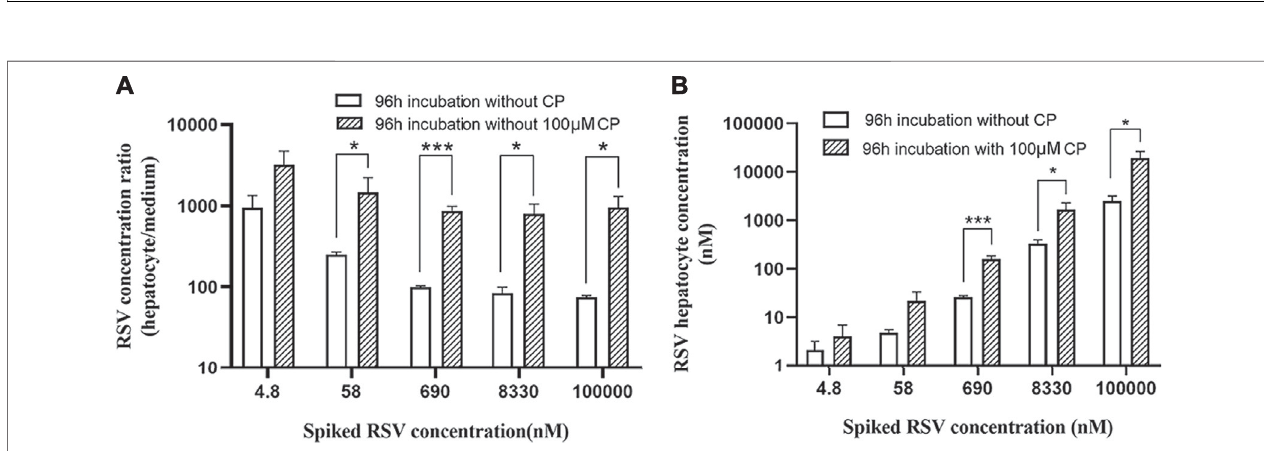
FIGURE 4 | Cell to medium concentration ratio (A) and intracellular concentration of RSV (B) in the presence and absence of CP after 96 h incubation. Data are presented as the mean ± S.D. (n (cid:2) 3). * p < 0.05, *** p < 0.001 vs 96 h incubation without CP.